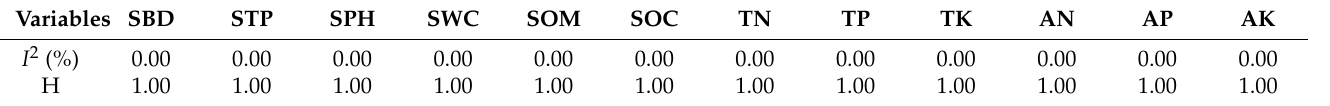
Table 2. Statistical results of variable